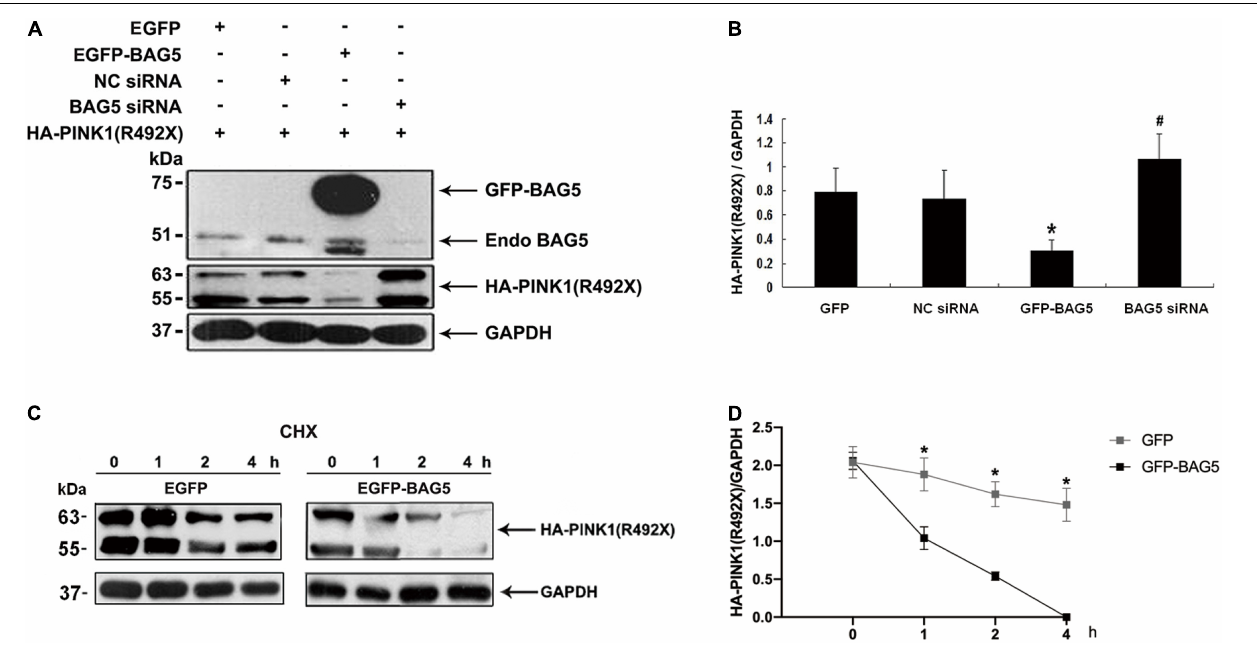
FIGURE 3 | BAG5 promotes R492X mutated PINK1 protein degradation. (A) HEK293 cells were transfected with EGFP, EGFP-BAG5, negative control siRNA (NC siRNA), BAG5 siRNA and HA-PINK1 R492X for 36 h. Cells extracts were analyzed by immunoblot using the specific antibodies. HA-PINK1 R492X was decreased in GFP-BAG5-expressing cells, whereas knockdown of BAG5 increased the level of HA-PINK1 R492X . (B) Quantitative data from A were shown. Values shown are the means ± SEM from the experiments. Level of statistical significance, * p < 0.05, # p < 0.01. (C) HEK293 cells were transfected for 36 h with either EGFP or EGFP-BAG5 with HA-PINK R492X , then cells were incubated for the indicated times in the presence of 100 mg/ml CHX. Cells were resuspended in lysis buffer, and the proteins were analyzed by immunoblot using anti-HA tag antibody. (D) The expression level of HA-PINK1 R492X was significantly lower in GFP-BAG5-overexpressing cells than in GFP-overexpressing cells. Values shown are the means ± SEM, level of statistical significance, * p < 0.05. All experiments were performed more than